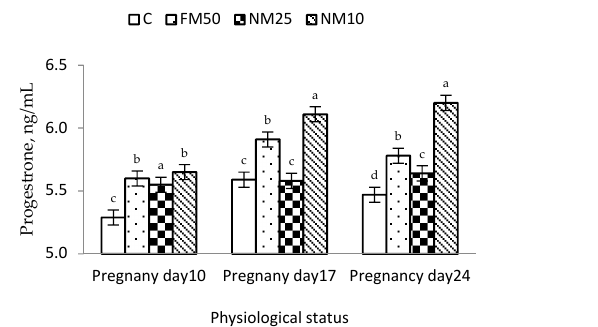
Table 7. Effect of the nanoencapsulated Moringa leaf ethanolic extract (MLEE) on the reproductive performance of female rabbits during the experimental period (Mean ± SEM).